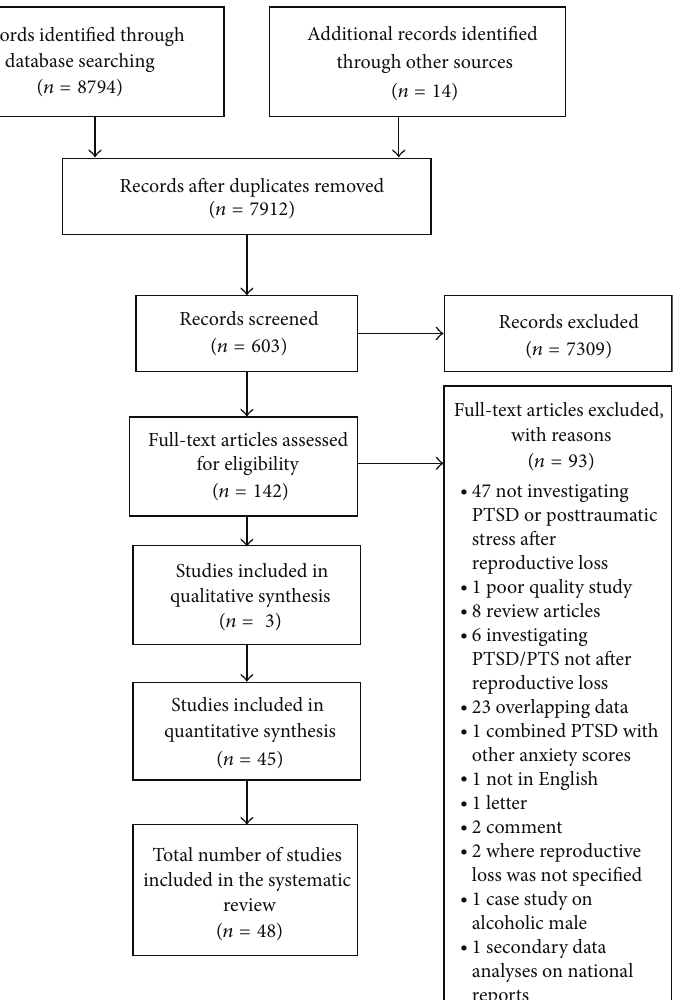
Figure 1: PRISMA flow